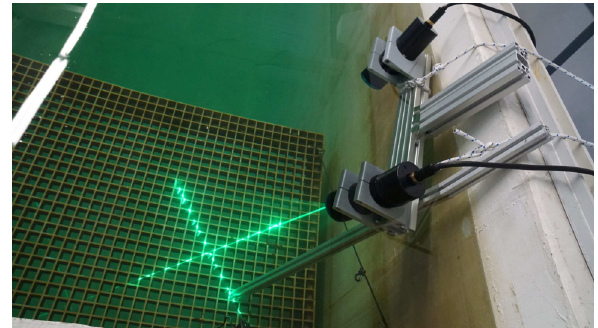
Figure 2. Prototype structured light underwater scanner projecting a laser cross in a water tank.